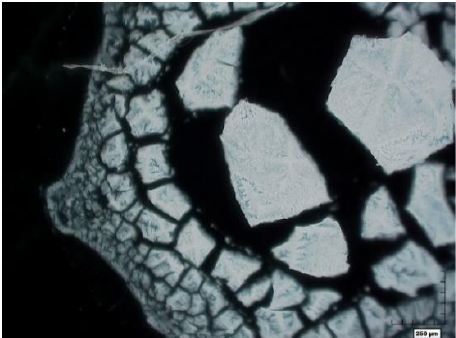
Figure 4—SiO drop on PET. The bar shown is 250 µm. Initial concentration of silica is 0.40 weight 2